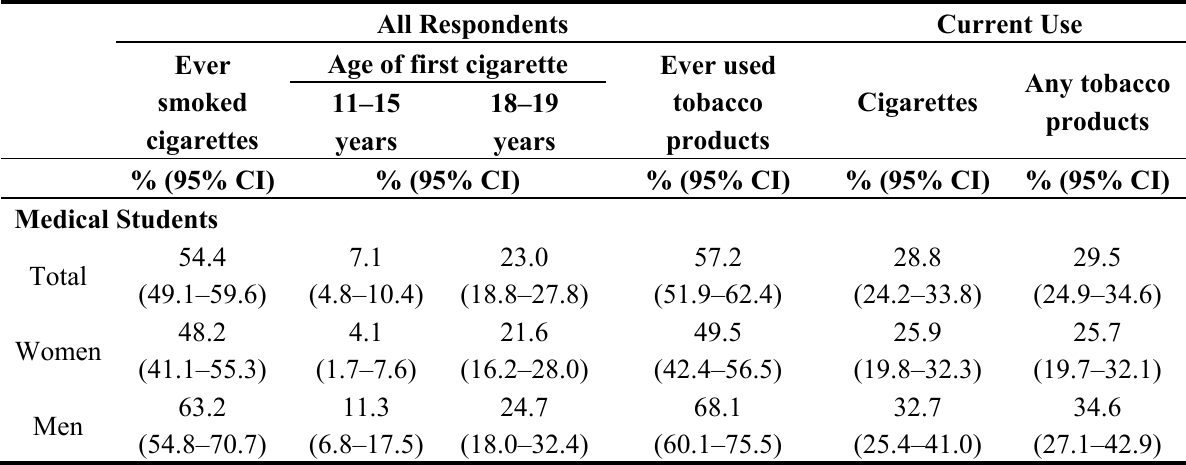
Table 2. Lifetime and Current Prevalence of Tobacco Use among Third-Year Health Professional Students (Greek Ghpss,